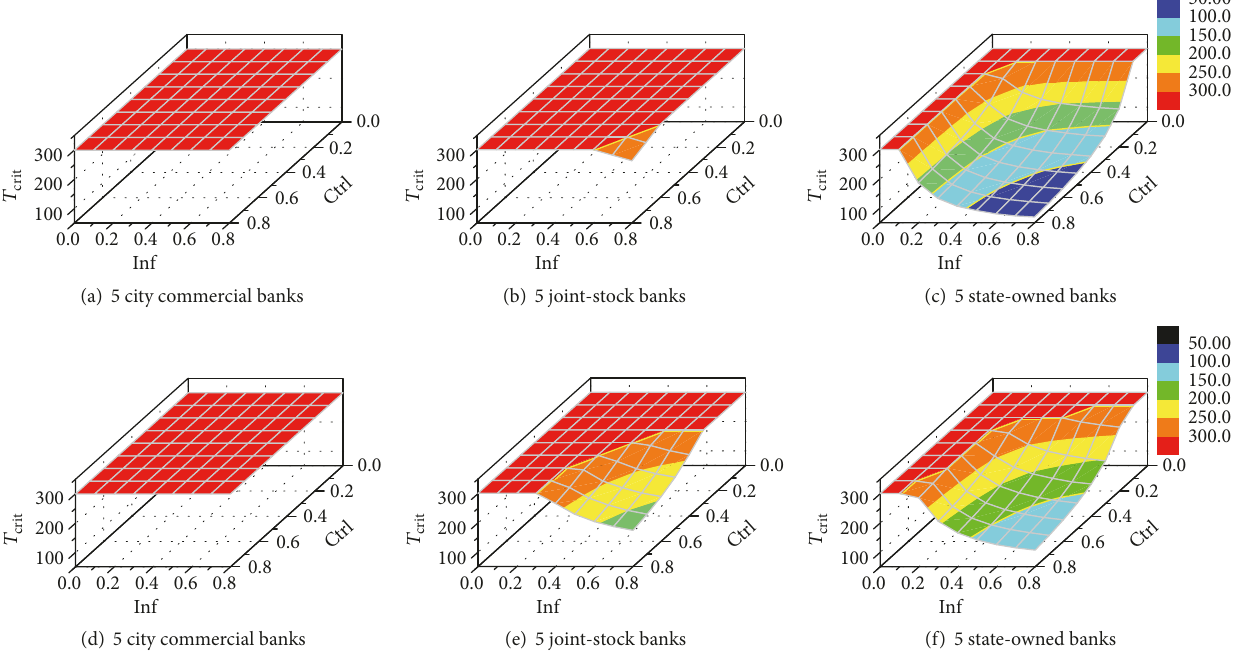
Figure 4: Effects of network contagion effect (Inf) and government control strength (Ctrl) on Critical Time ( 𝑇 crit ).